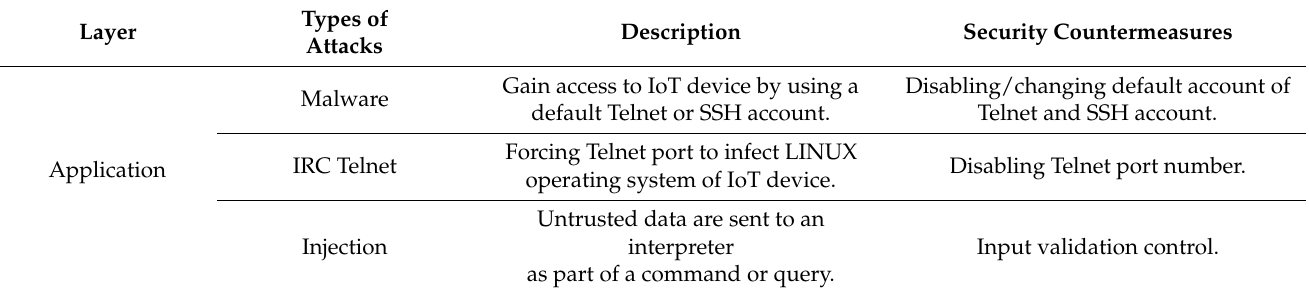
Table 9. The attack and countermeasures on the application layer.